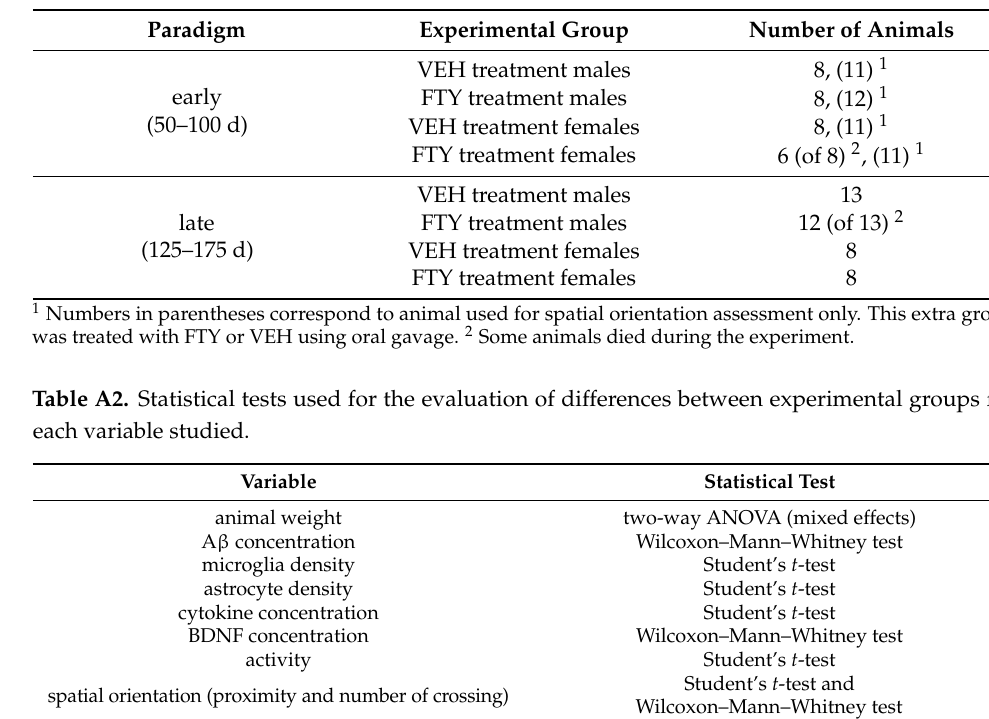
Table A1. Summary of experimental groups.